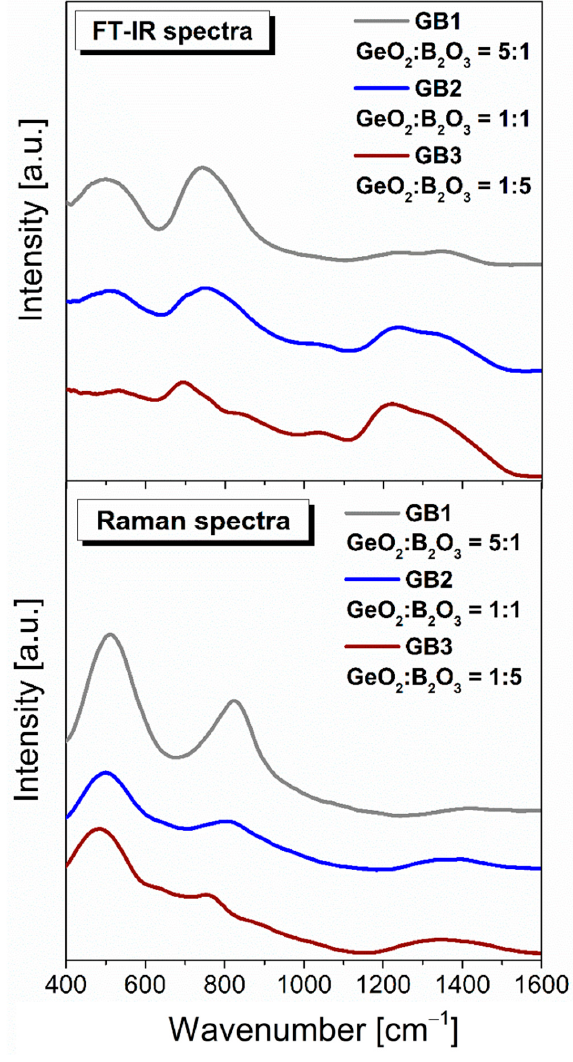
Figure 9. Infrared and Raman spectra of investigated glass samples with GeO 2 /B 2 O 3 ratio (5:1, 1:1, and 1:5).